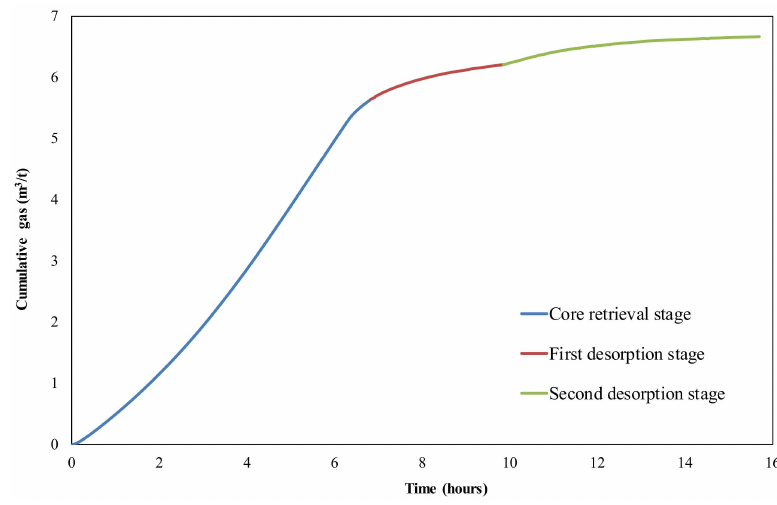
Figure 7. The evolution of cumulative gas volume of the observed shale core sample.